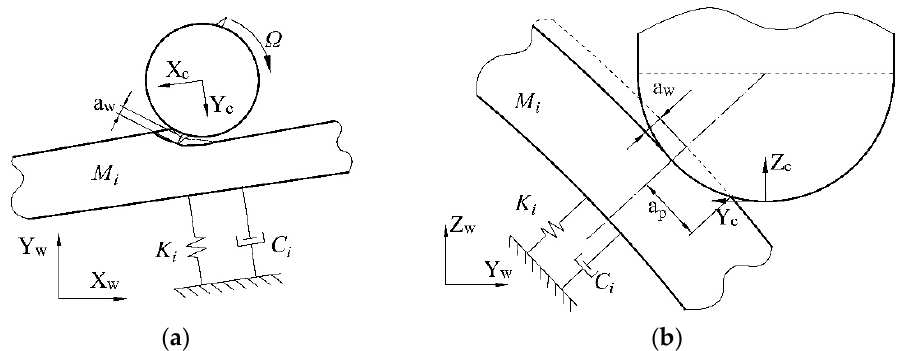
Figure 9. Geometries diagram of the cutting and vibration in the milling process ( a ) in the view of the Z w -direction; ( b ) in the view of the X w -direction.